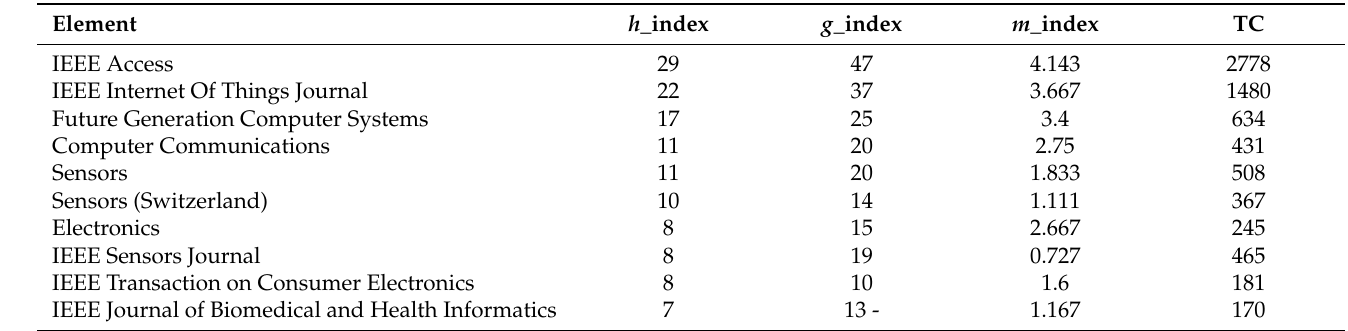
Table 4. Top 10 Journals with h , g and m index as well as total citation counts based on all seven databases.